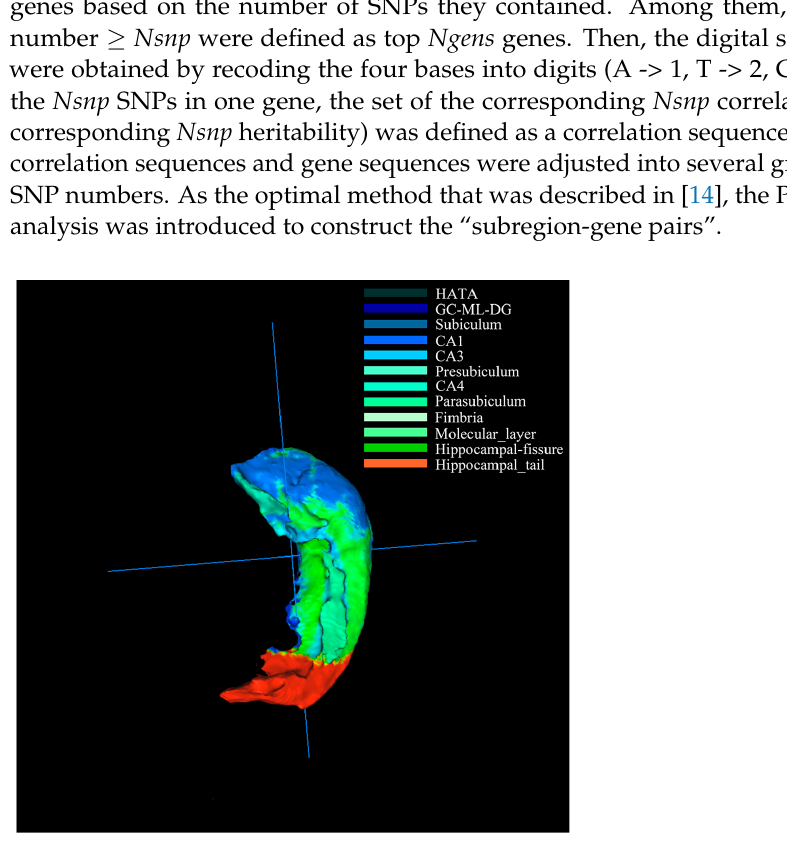
Figure 2. The anatomical representation of the 12 hippocampal subregions. The color represented different subregions. HATA = the hippocampus amygdala transition area; GL_ML_DG = the granule cell layer and molecular of the dentate gyrus; CA1 = cornu ammonis 1 region; CA3 = cornu ammonis 3 region; CA4 = cornu ammonis 4